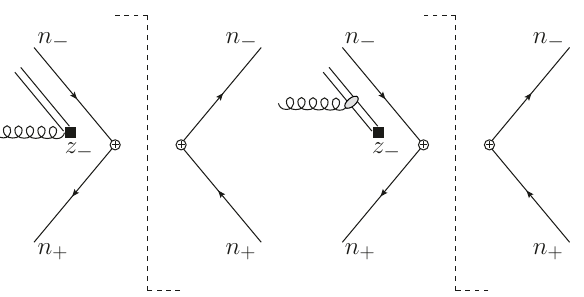
. The S 2 (cid:24) ). (cid:7)